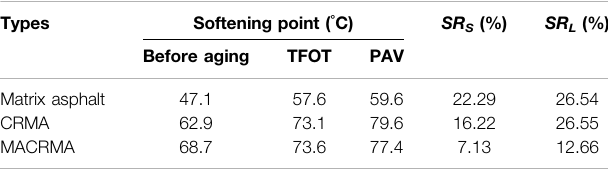
TABLE 5 | Ductility test results of three kinds of asphalts at different aging stages. Types